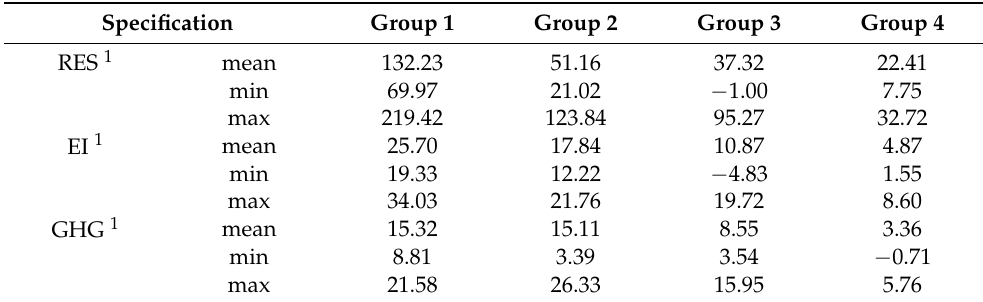
Table 7. Numerical characteristics of indicators of the level of achievement of energy policy targets in groups of Member